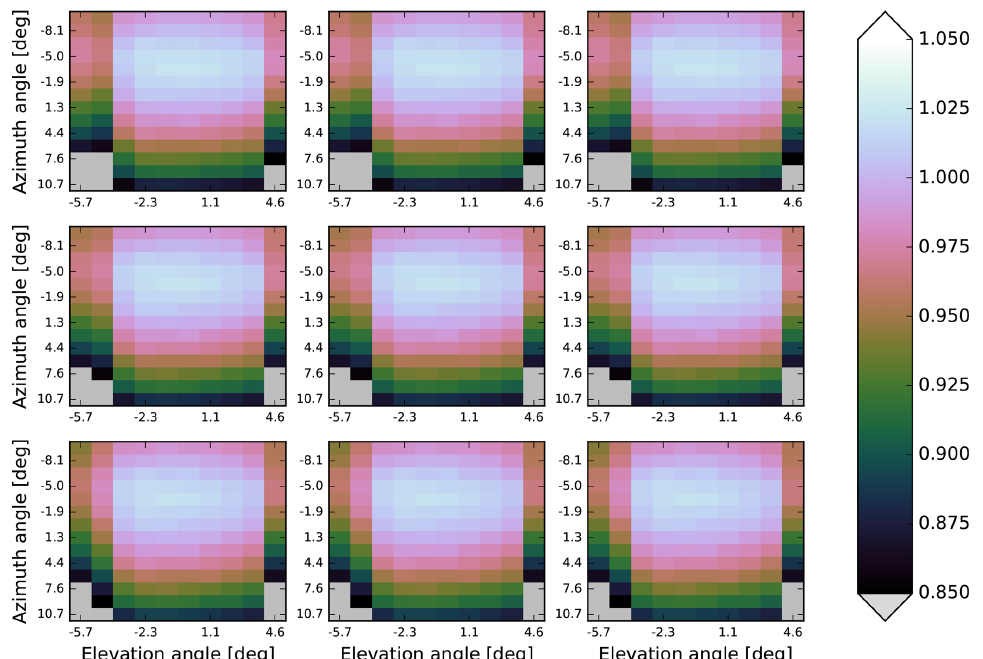
Figure 21. The relative irradiance response of the instrument as a function of azimuth angle ϕ and elevation (cid:15) at a number of pixels (figures correspond to different pixel locations on the detector) for the NIR detector. The signal shows a smooth dependence on the azimuth and elevation angle per pixel and is similar for all